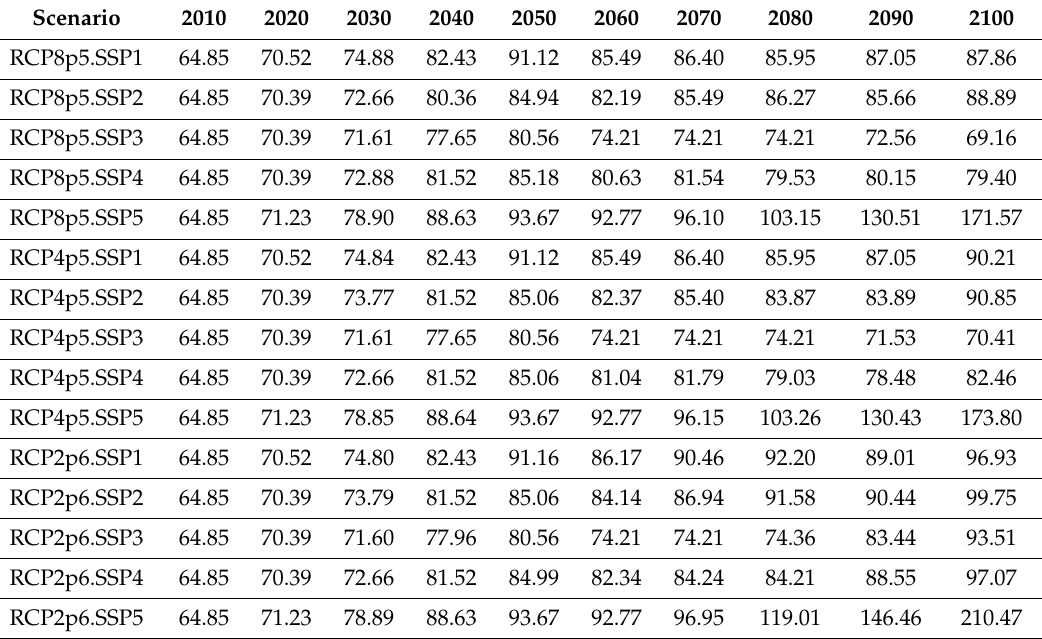
Table A6. Prices—Sawlogs (National average price per m 3 , in USD (exchange rate in 2010)).